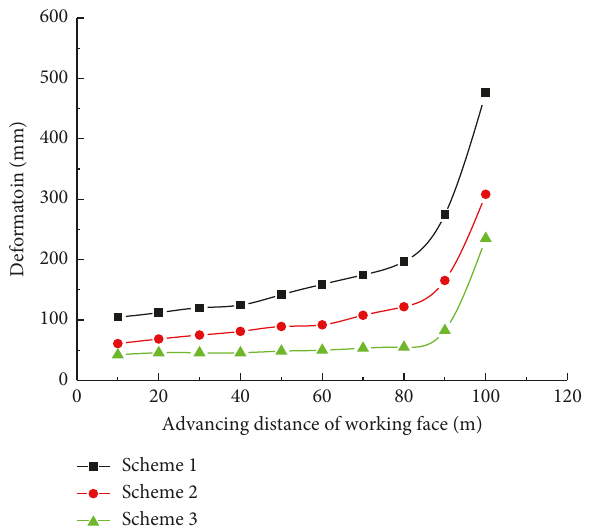
Figure 11: Main retracement channel: major wall